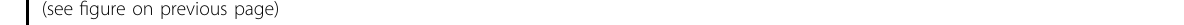
Fig. 3 Nec-34 directly inhibits the kinase activity of RIPK1. a The in vitro kinase activity assay. 293T cells were transfected with HA-tagged FL- RIPK1 (left) or kinase domain of RIPK1 (residues 1 – 330) (middle) for 24 h. Cells were then lysed with Nonidet P-40 buffer 24 h after transfection. The cell lysates were immunoprecipitated with anti-HA antibody-conjugated agarose and divided equally into fi ve or four parts. Divided immunocomplexes were pretreated with 20 μ M Nec-1s, Nec-34, or Nec-34i for 10 min. Kinase reactions were initiated by 20 μ M ATP, and the reactions were carried out at 30 °C for 30 min. Recombinant hRIPK1 (residues 1 – 330, 0.5 μ M) puri fi ed from Sf-9 insect cells was pretreated with 10 μ M Nec-1s or Nec-34 for 30 min as indicated. The kinase reactions were initiated by 200 μ M ATP, and the reactions were carried out at 30 °C for 30 min (right). The samples were analyzed by western blotting with indicated antibodies. b The Tm value of recombinant hRIPK1 in Nec-34, Nec-34i, Nec-1s or Nec-1i treatment groups were compared to control group and presented as Δ Tm for protein thermal shift assay. Recombinant hRIPK1 (residues 1 – 330, 2 μ M) puri fi ed from Sf-9 cells was treated with indicated compounds for 1 h. Protein thermal stability was analyzed through the differential scanning calorimetry by real-time PCR and the Tm values were calculated by Protein Thermal Shift Software. Three replicates for each reaction were performed. c ADP-Glo ™ Kinase Assay of hRIPK1. Recombinant hRIPK1 (residues 1 – 330, 1 μ M) puri fi ed from Sf-9 cells was pretreated with different concentrations of Nec-1s, Nec-34 for 30 min as indicated. The kinase reactions were initiated by 111 μ M, 333 μ M, 1 mM and 3 mM ATP as indicated, and the reactions were carried out at 30 °C for 2 h, and then the amount of ADP produced during the kinase reaction was detected by ADP-Glo ™ Reagent. d 293T cells were transfected with Flag-tagged WT-RIPK1 (residues 1 – 330), or S161A mutant for 24 h. Nec-34 or Nec-1s (10 μ M) was added at 6 h after transfection. The cells were lysed with Nonidet P-40 buffer and analyzed by western blotting with indicated antibodies. e , f RIPK1-de fi cient Jurkat cells were infected with retrovirus expressing HA-tagged WT-hRIPK1 and HA-tagged hRIPK1 S161A, respectively, by the Tet-On Advanced Inducible Expression System. Reconstituted Jurkat cells were treated with 1 μ g/mL doxycycline for 48 h to induce the expression of RIPK1. The cells were then pretreated with 100 nM SM-164 for 2 h ( e ) or 100 nM 5Z7 for 1 h ( f ), and then 100 ng/mL TNF α and 50 μ M zVAD.fmk were added for additional 24 h. g Reconstituted hRIPK1 S161A Jurkat cells were pretreated with TNF α /SM-164/zVAD.fmk as indicated, and then were lysed with 0.5% Nonidet P-40 buffer and analyzed by western blotting with indicated antibodies. h , i 293T cells were transfected with HA-tagged RIPK1 (residues 1 – 330) L70A, or L129M mutant expression plasmids for 24 h. Nec-34 and Nec-1s (10 μ M) were added 6 h after transfection. The cells were lysed with Nonidet P-40 buffer and analyzed by western blotting with indicated antibodies. The cell death in e , f were measured by CellTiter-Glo assays. The results shown depict the means ± SEM of n = 3 independent biological experiments. P -values were calculated by two-tailed Student ’ s t -test (** P < 0.01, *** P < 0.001, **** P <